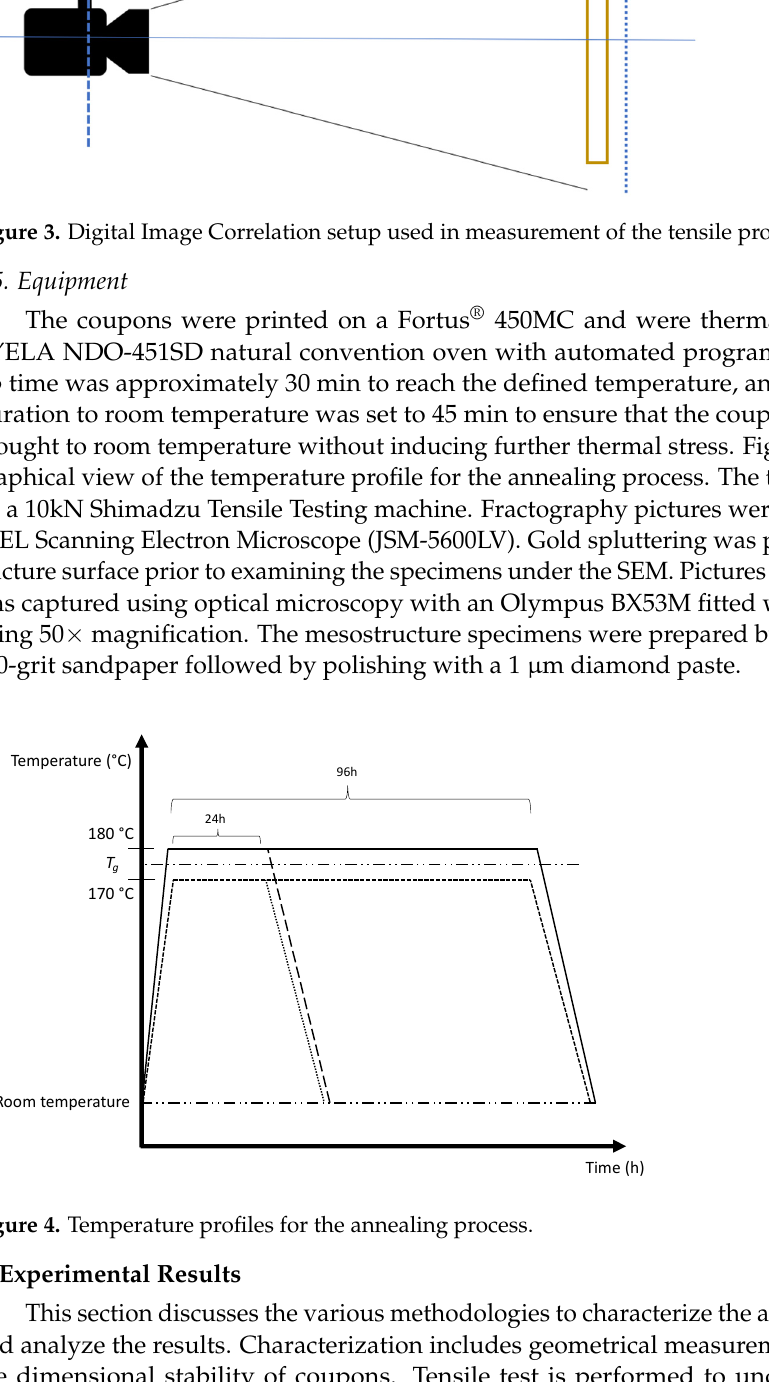
Figure 3. Digital Image Correlation setup used in measurement of the tensile properties.